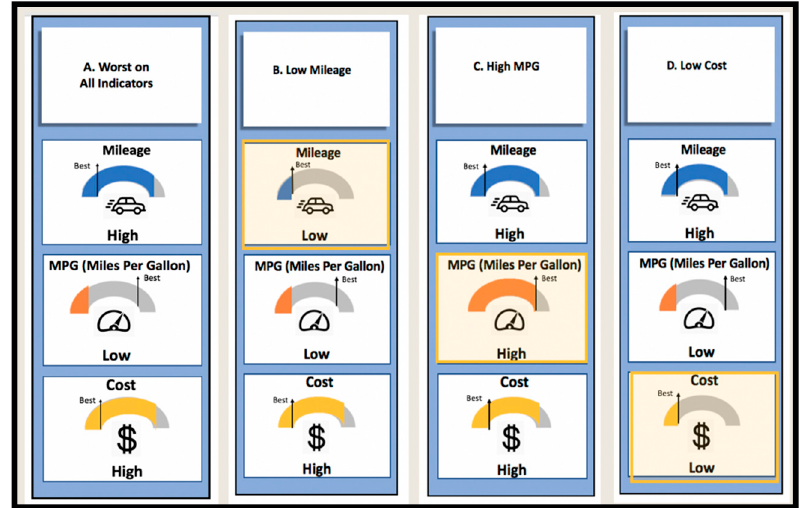
Figure 2. Examples of the cards used for each attribute. In these examples, each attribute is set to its worst level.